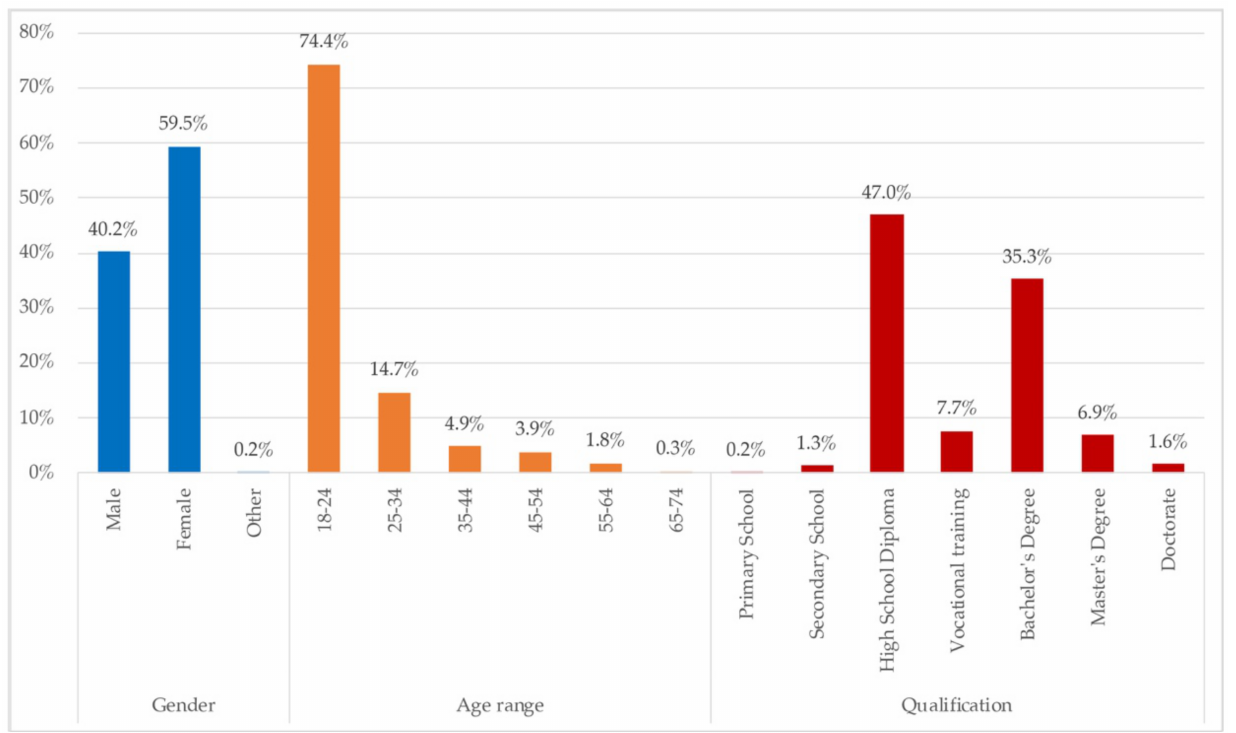
Figure 1. Sociodemographic results of participants.